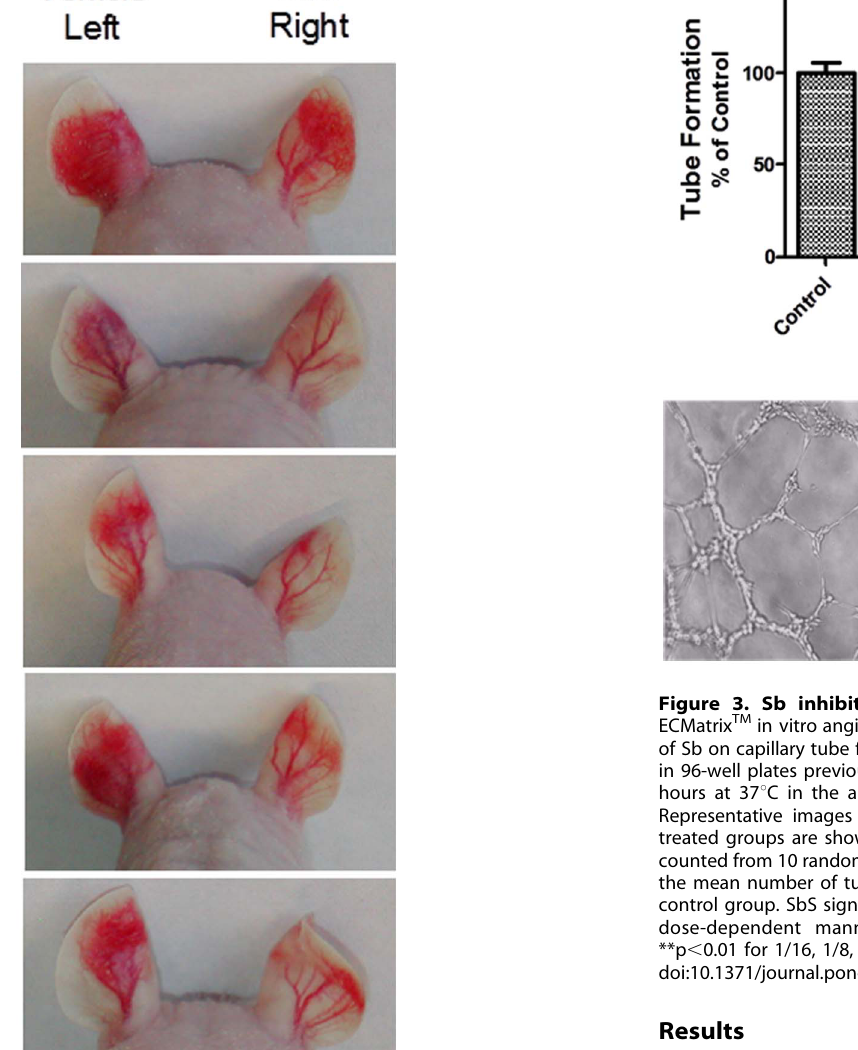
Results were expressed as mean 6 SE or mean 6 STDEV.